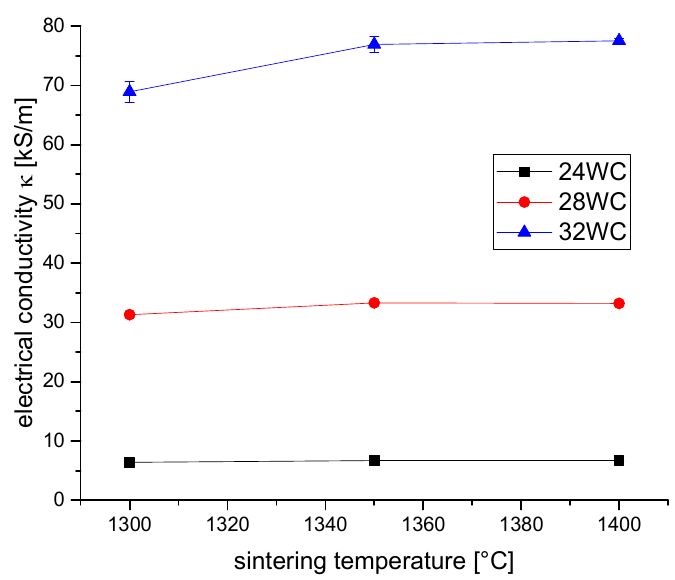
Figure 5. Electrical conductivity κ of TZP-WC composites depending on composition and sinter- ing temperature.